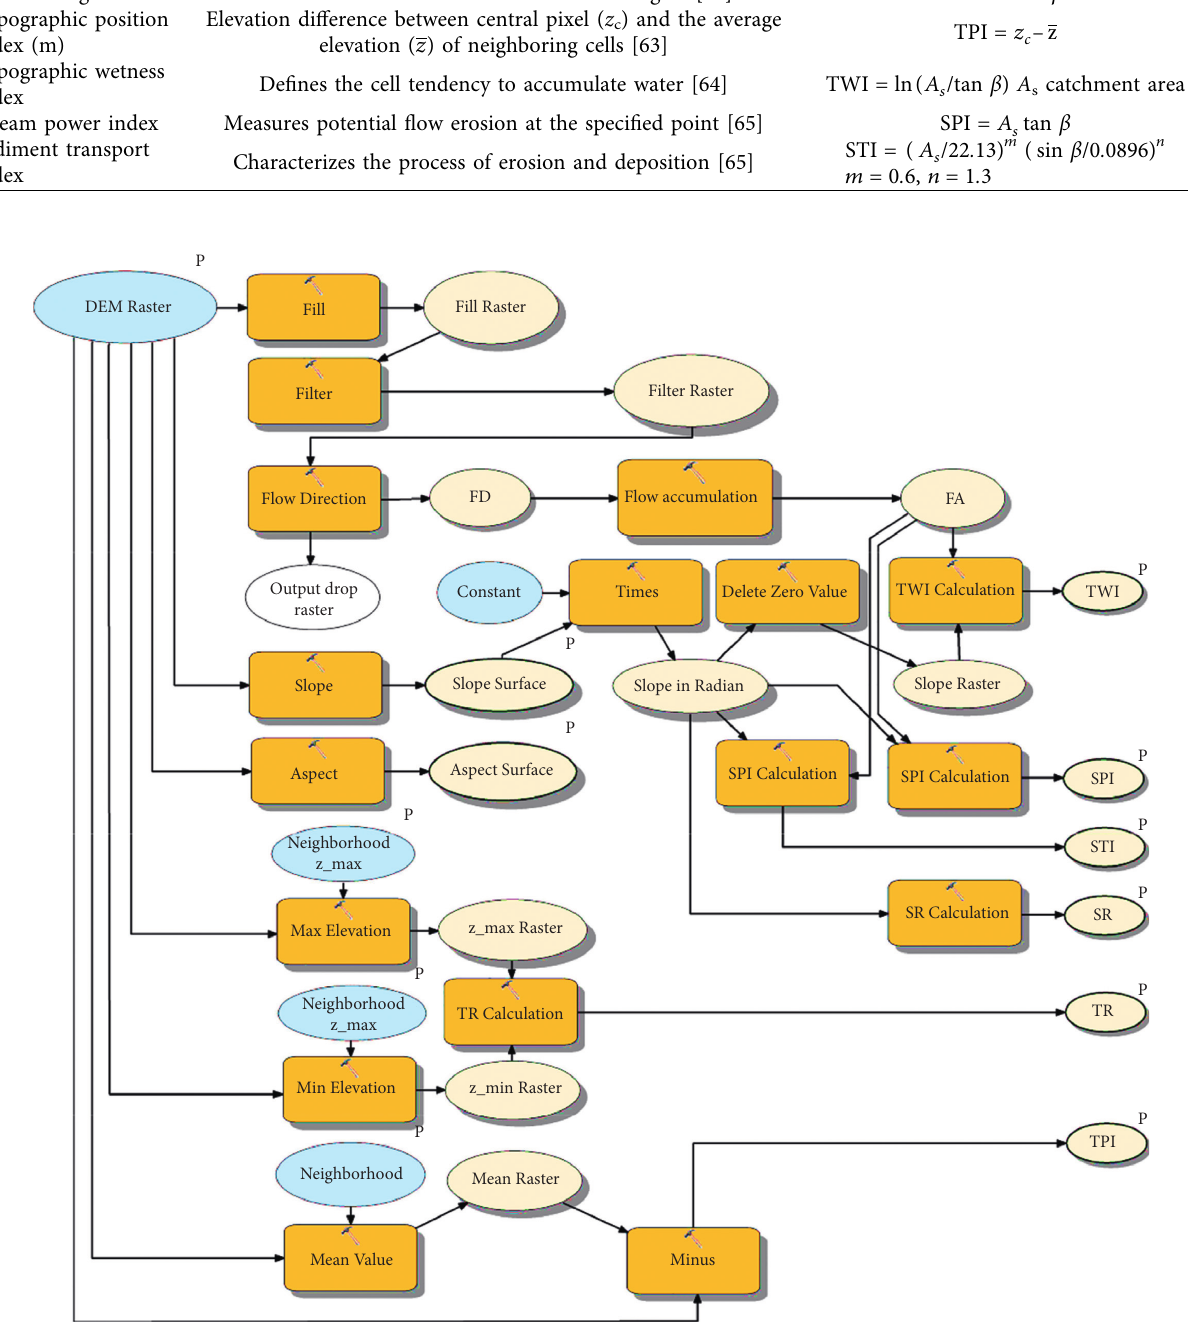
Figure 9: Geoprocessing tool in ArcGIS to calculate topographic metrics.